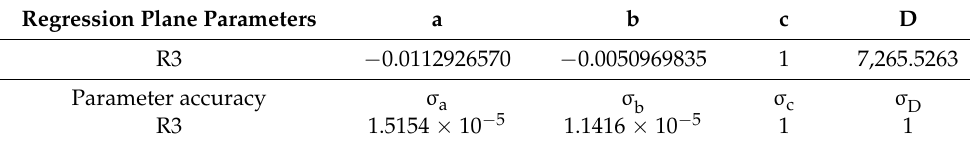
Table 1. Regression plane parameters [m] for the selected case.